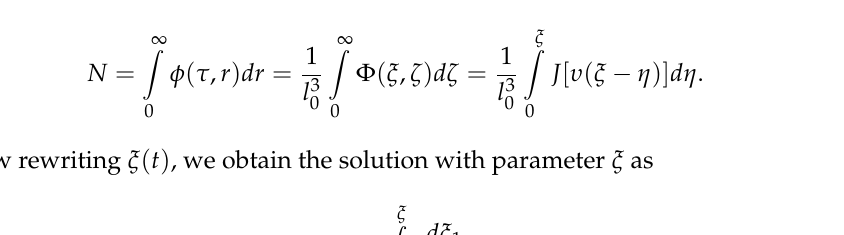
and time t = τ depending on the modified time ξ . τ 0 T 0